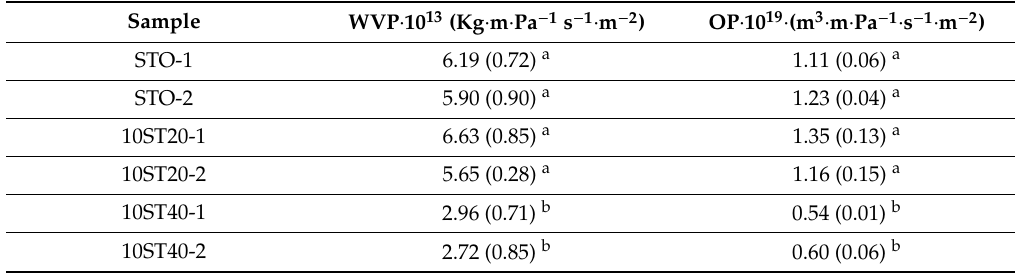
Table 2. Values of water vapor permeation (WVP) and oxygen permeation (OP) of STO (reference), 10ST20 and 10ST40 formulations. Each material was characterised twice and both individual results are shown, referred as − 1 and − 2. a : no significant di ff erences regarding control STO; b : significant di ff erences regarding